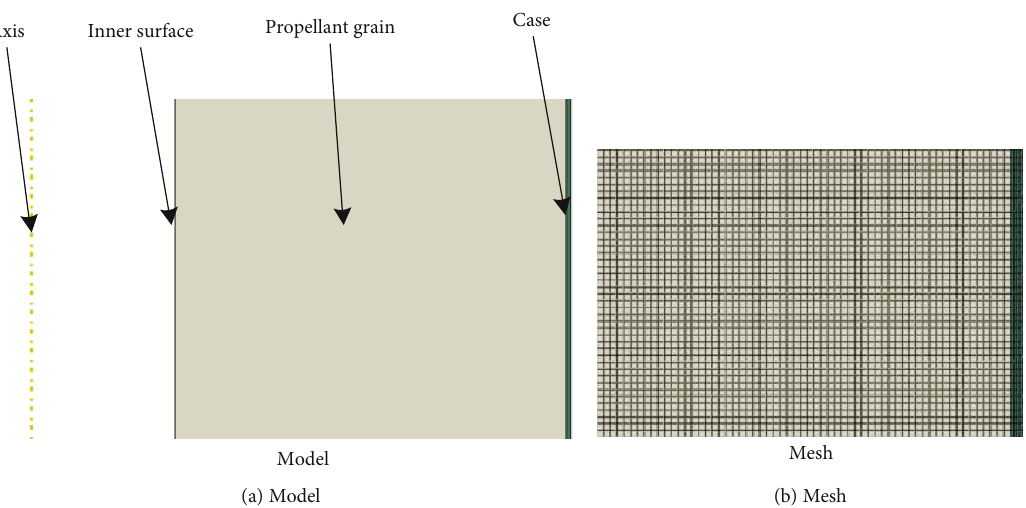
Figure 2: The model of numerical calculation.